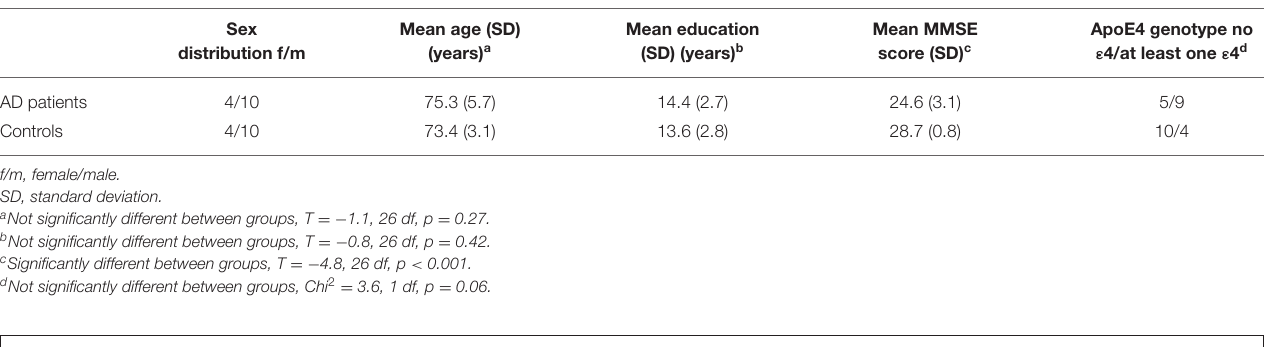
Frontiers in Neurology |